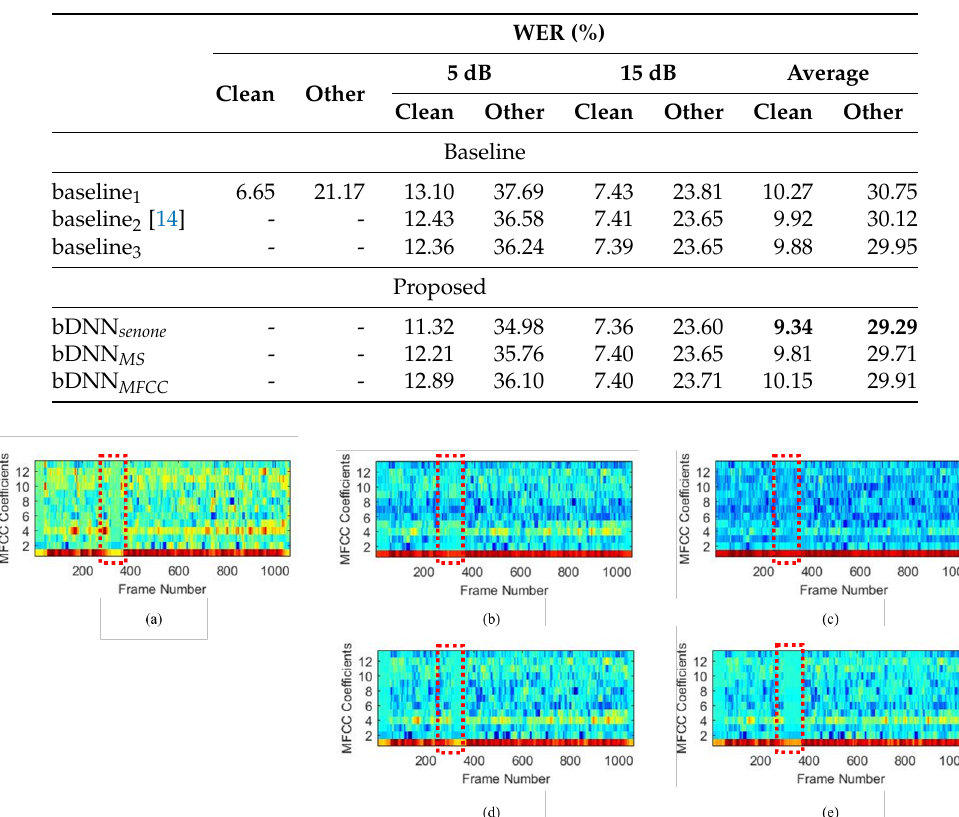
Table 4. Performance (WER in %) comparison using LibriSpeech database with 4-gram language model when the motor is on.